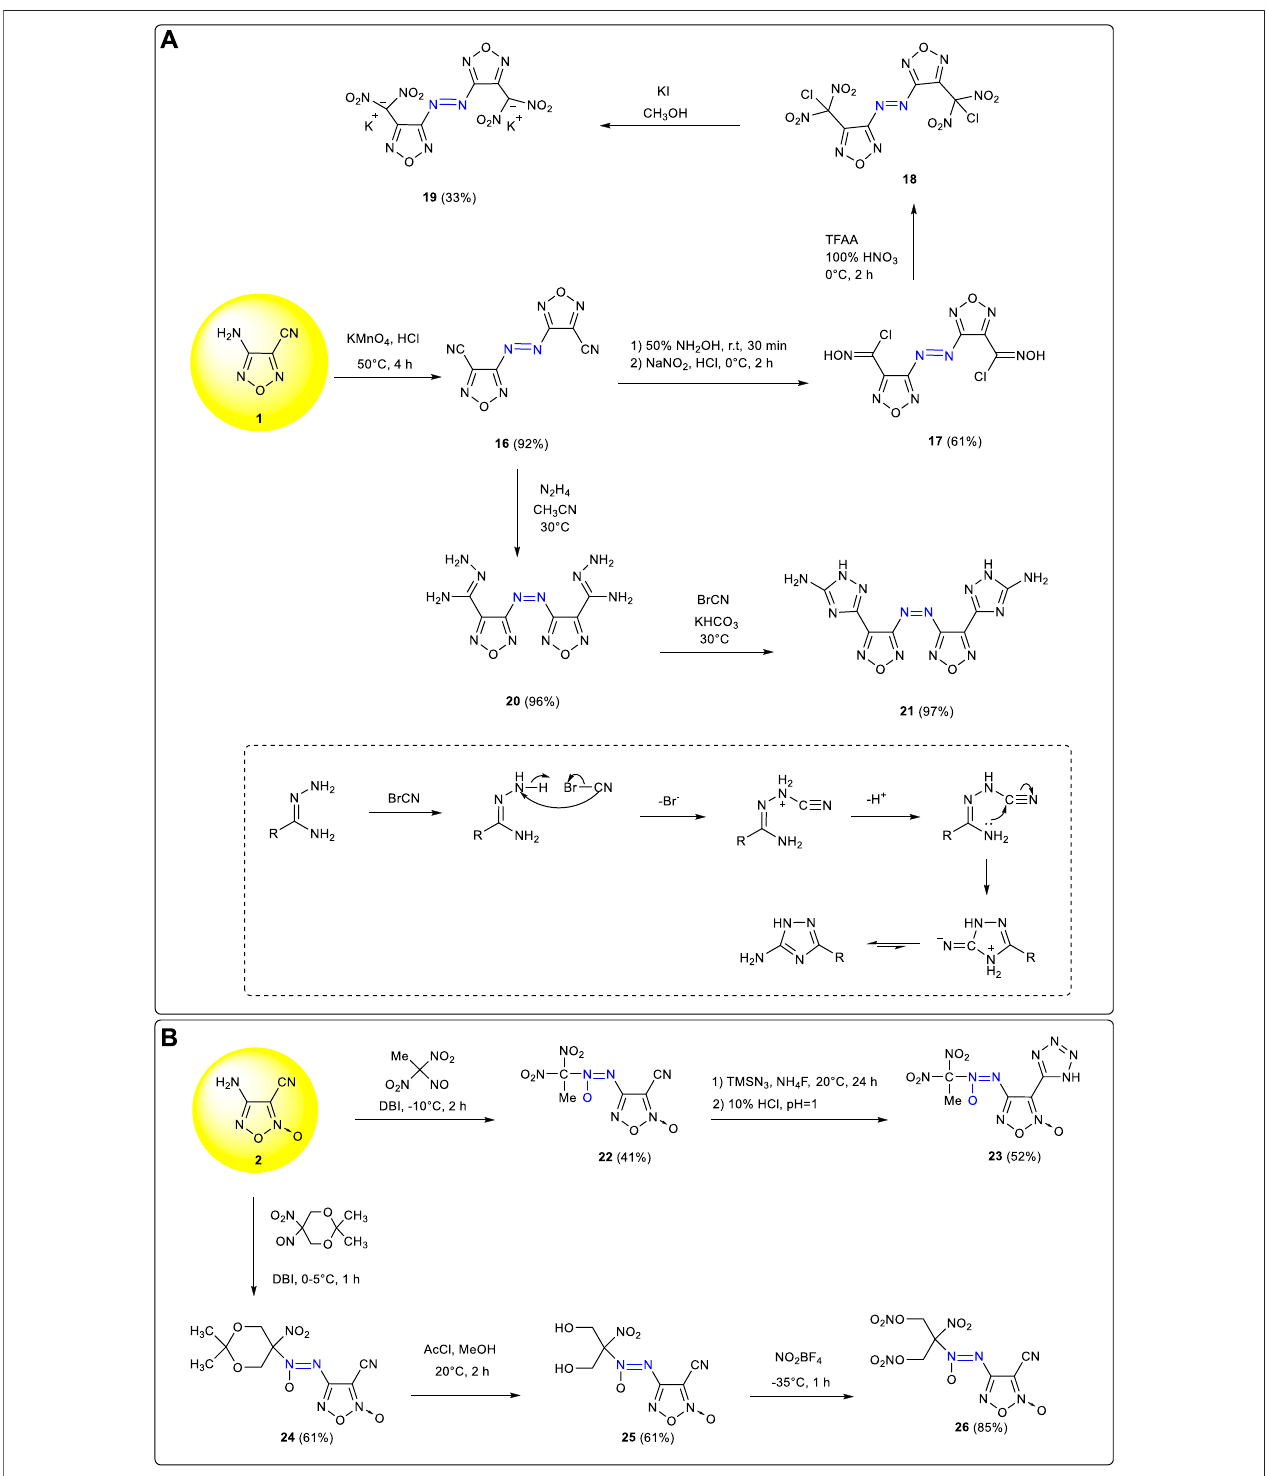
SCHEME 2 | (A) Synthesis of 19 and 21 and the mechanism of cyclization process via hydrazide and BrCN; (B) Synthesis of 23 and 26 by oxidative coupling.